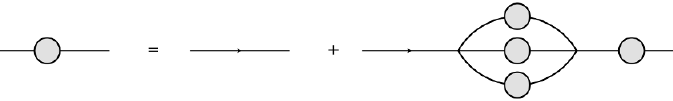
Figure 1. The Schwinger-Dyson equation for the exact